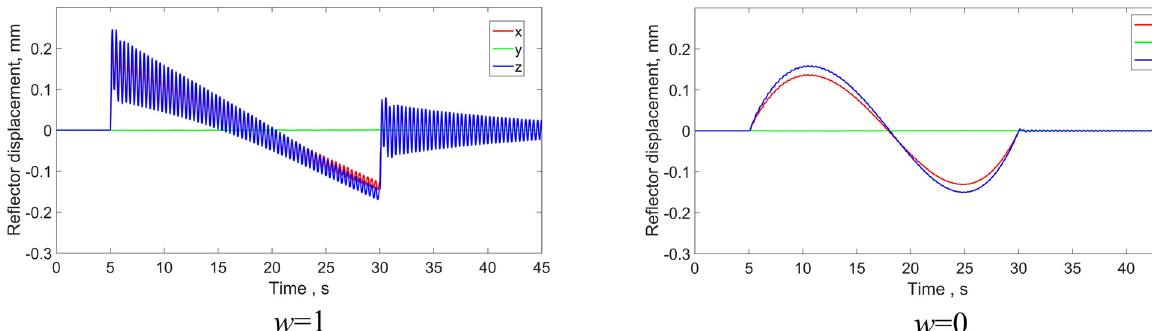
Figure 22: Re fl ector displacements for case 3.